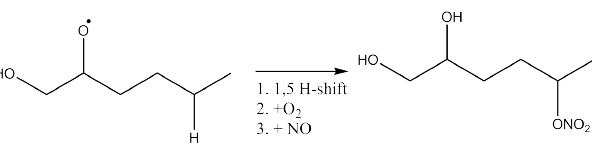
Figure 45. Alkoxy H-shift isomerization leading to dihydroxy ni- Figure 5. Alkoxy H-shift isomerization leading to dihydroxy nitrate trate formation for 1-hexene. formation for 1-hexene.